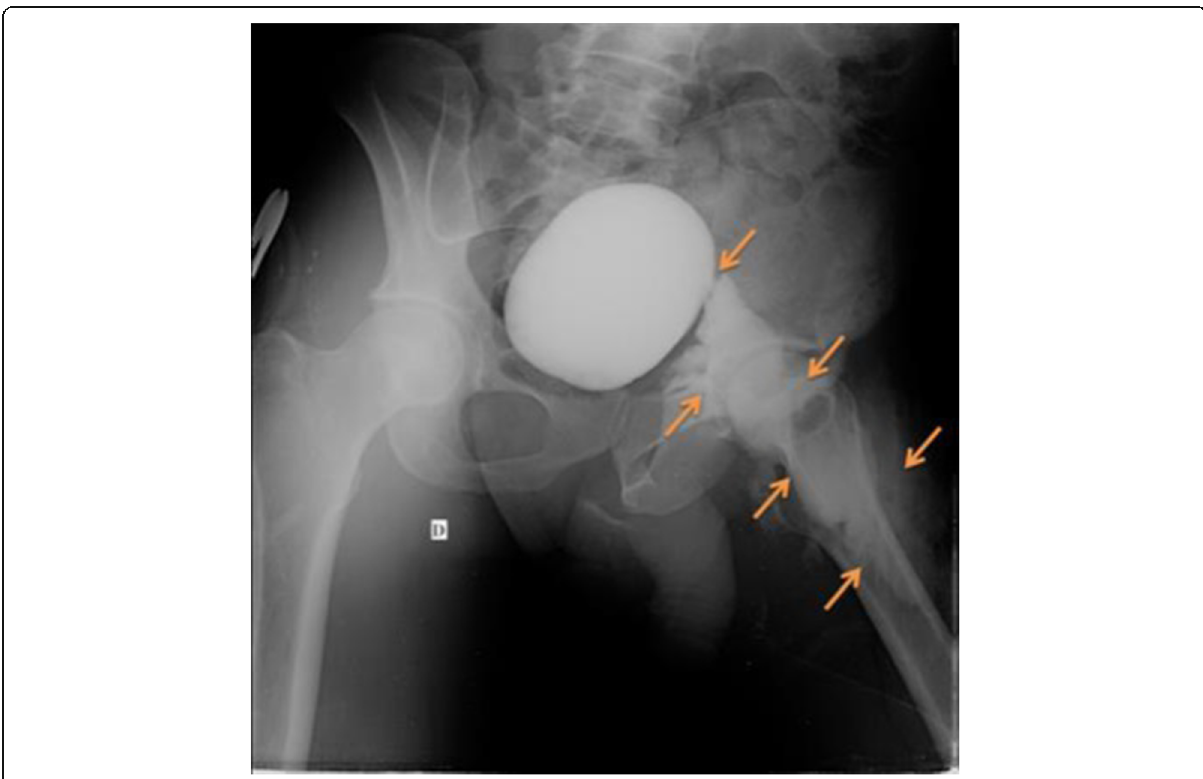
Fig. 6 Uretro-cystographic image of the vesico-cutaneous fistula passage (arrow) on the per voiding